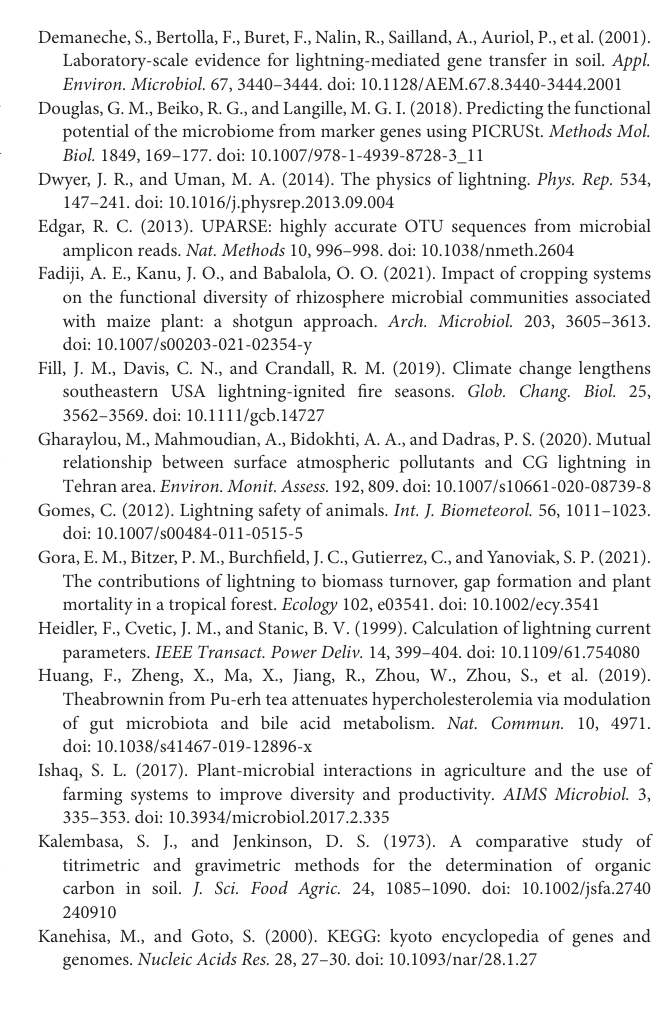
Supplementary Figure S1 | Rarefaction curves of bacterial OTUs in different samples. Lighting represents a sample 10m from the lightning rod; Control indicates that the distance between the sample and the lightning rod is > 1,500